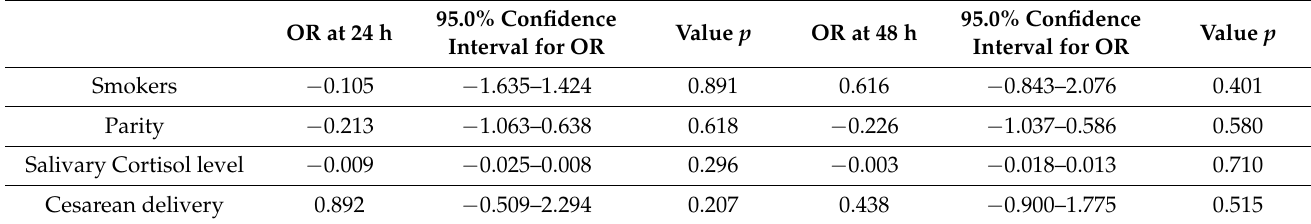
Table 4. Multivariate logistic model for LACH score lower than 8 at 24- and 48-h